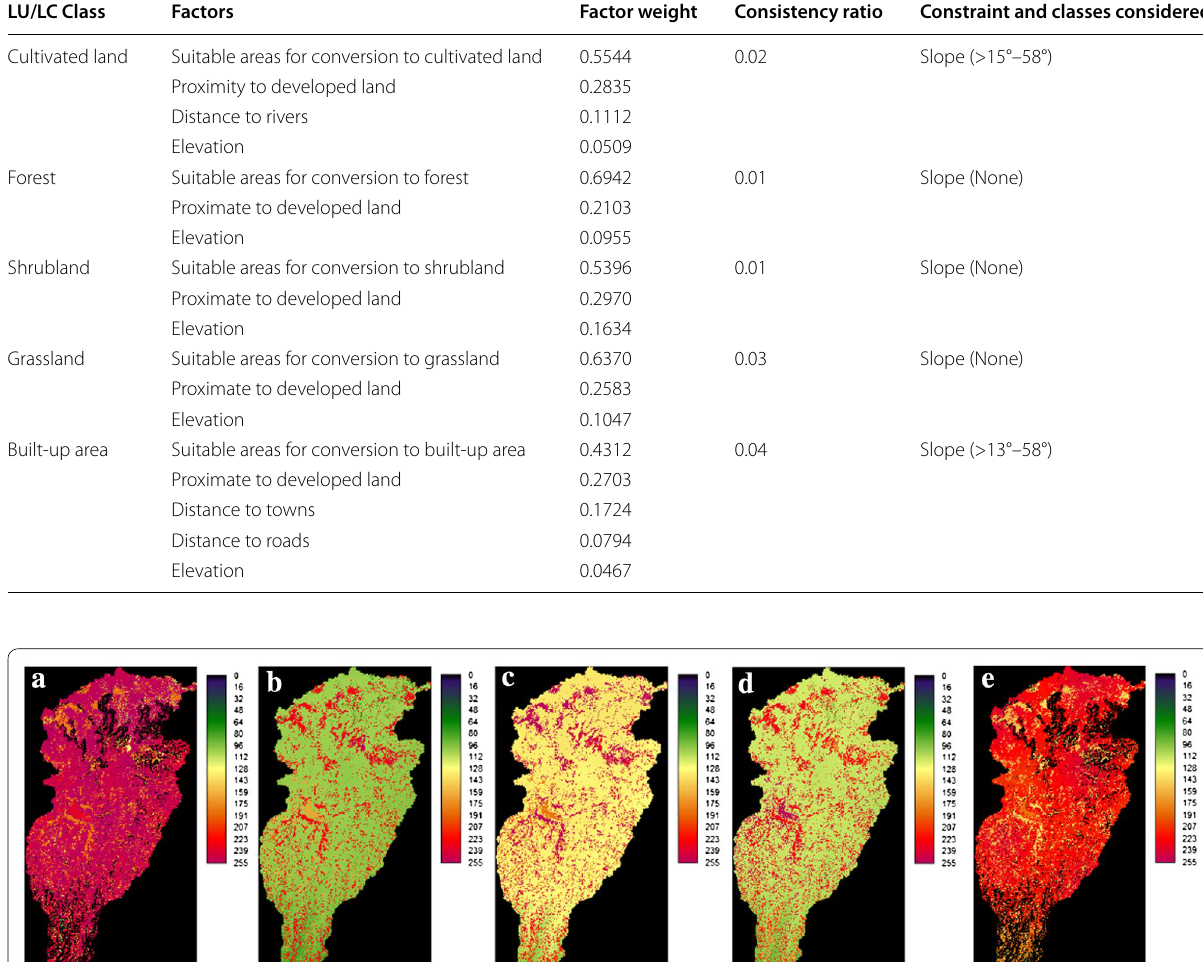
Table 4 Factors and constraints considered and their weights for predicting LU/LC conditions in the Andassa watershed LU/LC Class